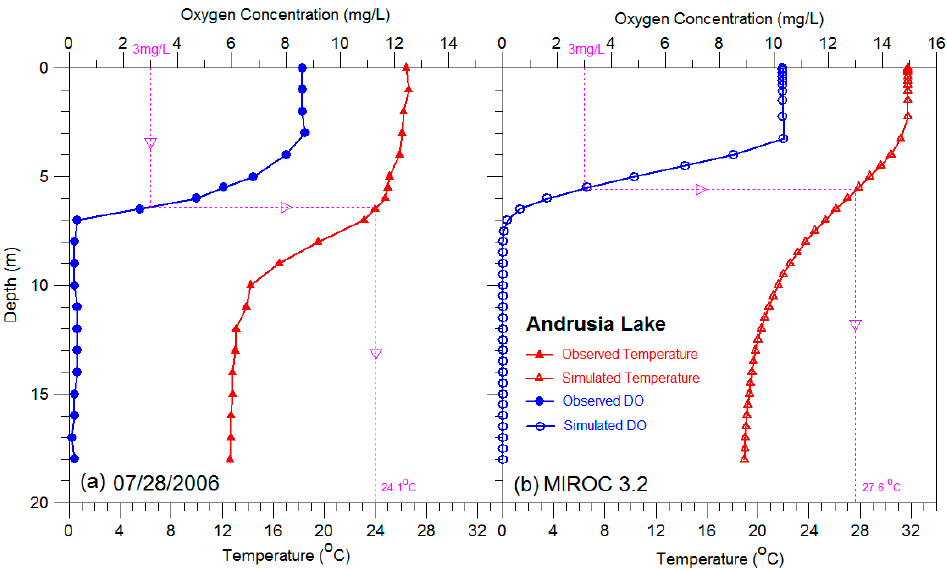
Figure 3. Observed and simulated temperature and dissolved oxygen profiles in Andrusia Lake for ( a ) 28 July 2006 and ( b ) MIROC 3.2 with calculated TDO3 equal to 24.1 °C and 27.6 °C, respectively. The depth is from the lake surface.